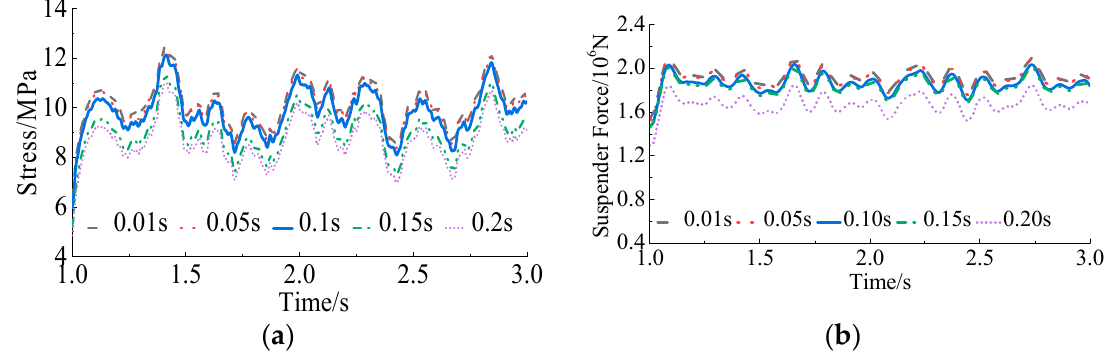
Figure 20. The time history plot of the stress in different suspender breaking durations: ( a ) the longitudinal beam; ( b ) the adjacent suspenders.